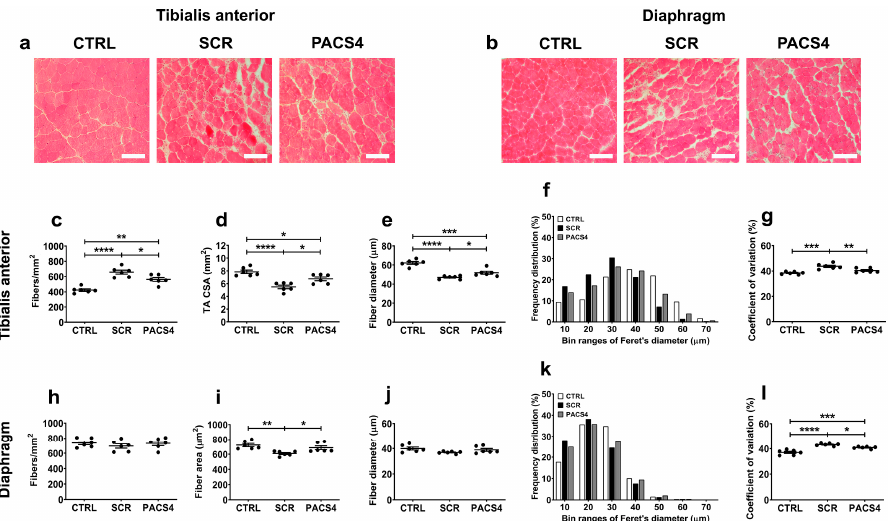
Figure 4. Improved muscle histopathology following longitudinal vivoPMO-PACS4 treatment. Histopathological changes in ( a ) the tibialis anterior (TA) and ( b ) the diaphragm (DIA) muscles were initially assessed by hematoxylin and eosin analysis. Representative images are shown at a magnification of × 100, scale bars = 100 µ m. Both muscles were further stained for laminin to identify the myofiber sarcolemma. The total number and size of ( c – g ) TA and ( h – l ) DIA myofibers were automatically scored by Fiji/MuscleJ software (version 1.53c, National Institutes of Health, Bethesda, MD, USA). ( c , h ) The fiber number per mm 2 of the muscle CSA, ( d ) the area of whole transverse TA muscle or ( i ) area of DIA fibers, ( e , j ) the mean of minimal Feret’s diameter of fibers, ( f , k ) a histogram of the frequency distribution of the fiber diameter and ( g , l ) the coefficient of variance of the fiber diameter are shown for the TA and DIA, respectively. Data are shown as means ± SEM; n = 6. Statistical comparison was by one-way ANOVA followed by Tukey’s multiple comparisons test; * p < 0.05, ** p < 0.01, *** p < 0.001, **** p <